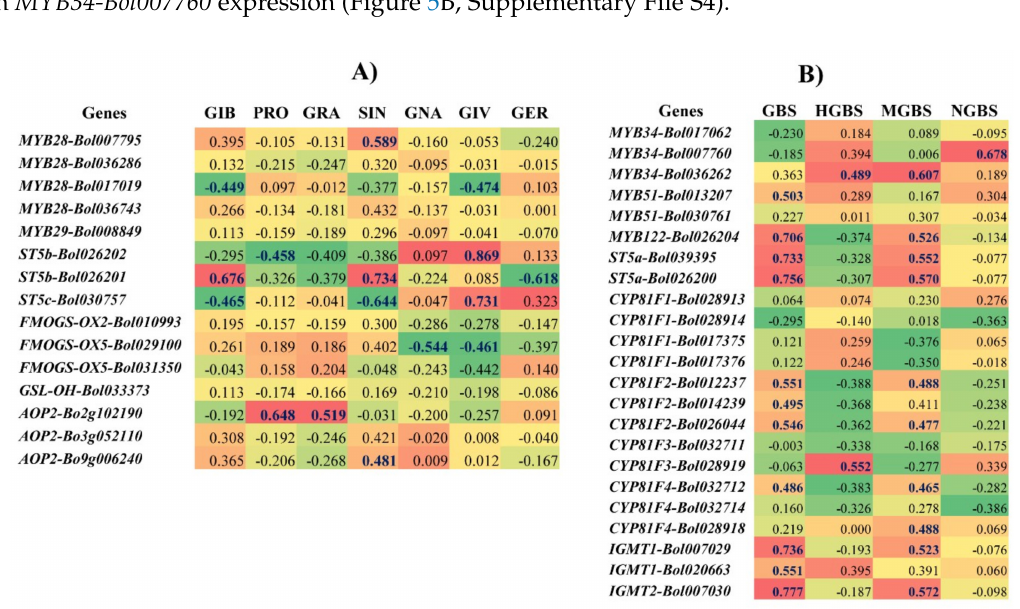
Figure 5. Heat maps showing correlation between the levels of aliphatic ( A ) and indole ( B ) glucosinolate components and expression of biosynthesis genes under four specific treatments (C, control; M1,